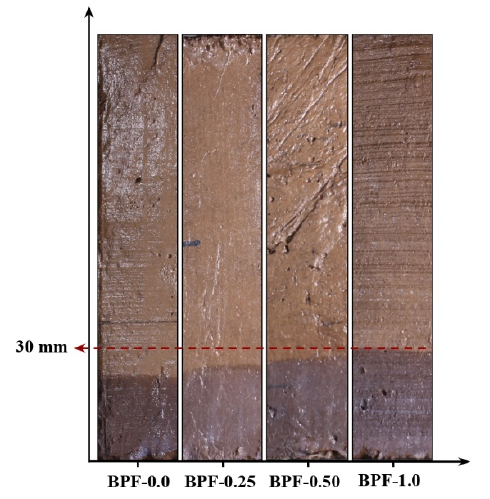
Figure 7. Representative capillary water rise of each earthen mix at Day 1.